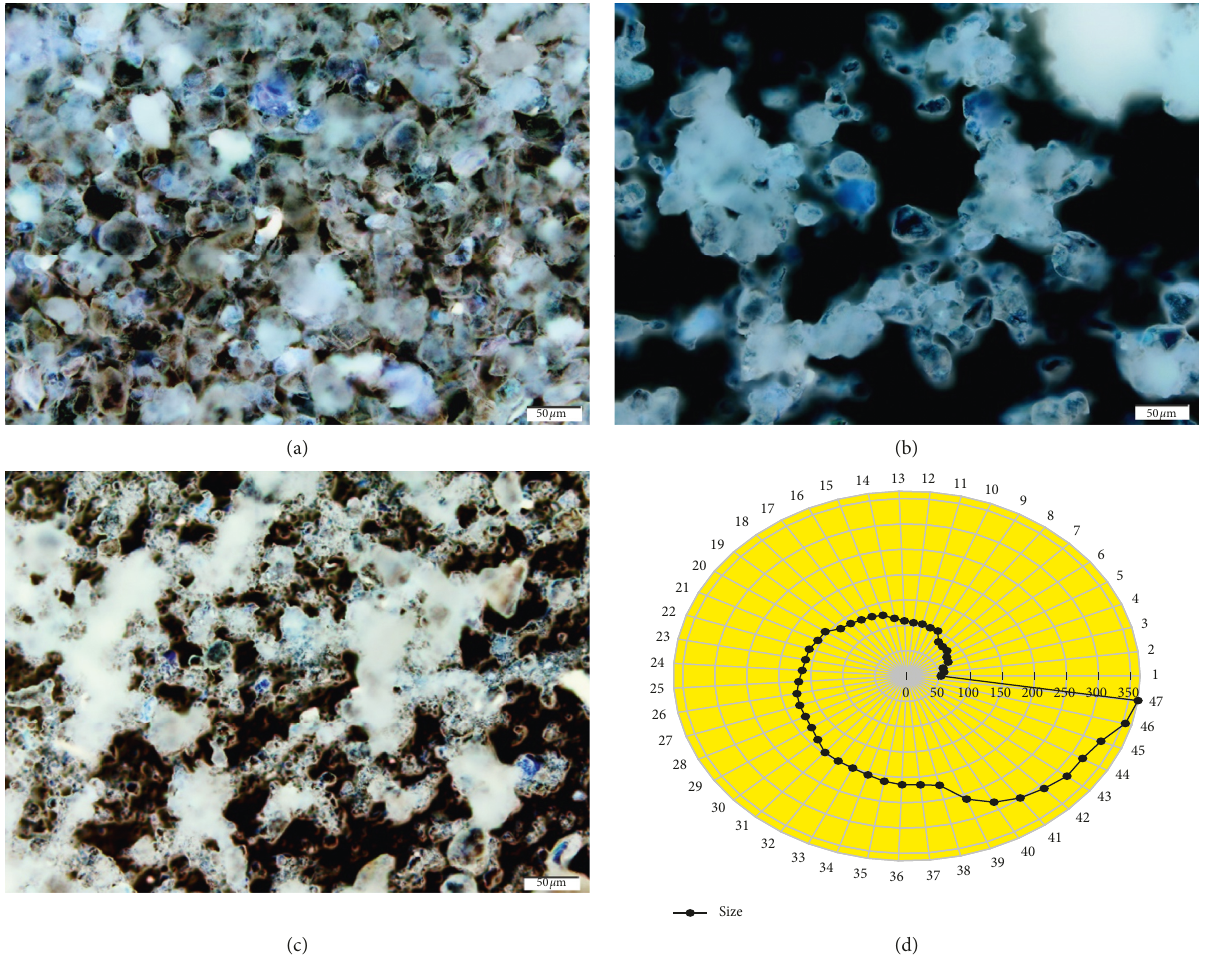
Figure 4: Three states and sizes of flocs during flocculation and sedimentation in experiments: (a) Particles. (b) Microflocs. (c) Macroflocs. (d) Size in experiments ( μ